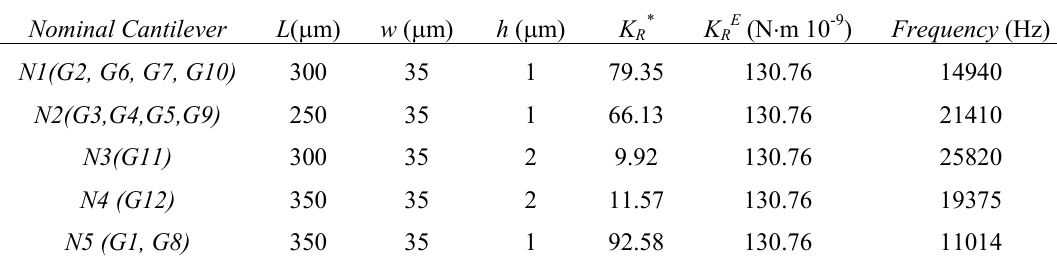
Table 5. Nominal cantilevers with ideal geometries. The associated tested cantilevers G1-G12 are shown in parenthesis in the first column. The K R* values are obtained from the average K RE values obtained experimentally. The ideal natural frequency for each nominal cantilever is also